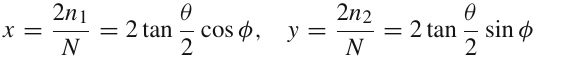
1 and n 2 to plot the discrete sur-